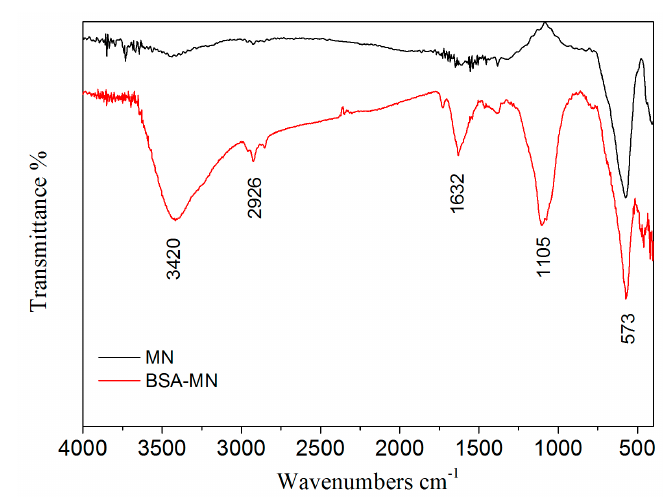
Figure 3. The FT-IR spectrum of MN ( black ) and BSA-MN ( red ).